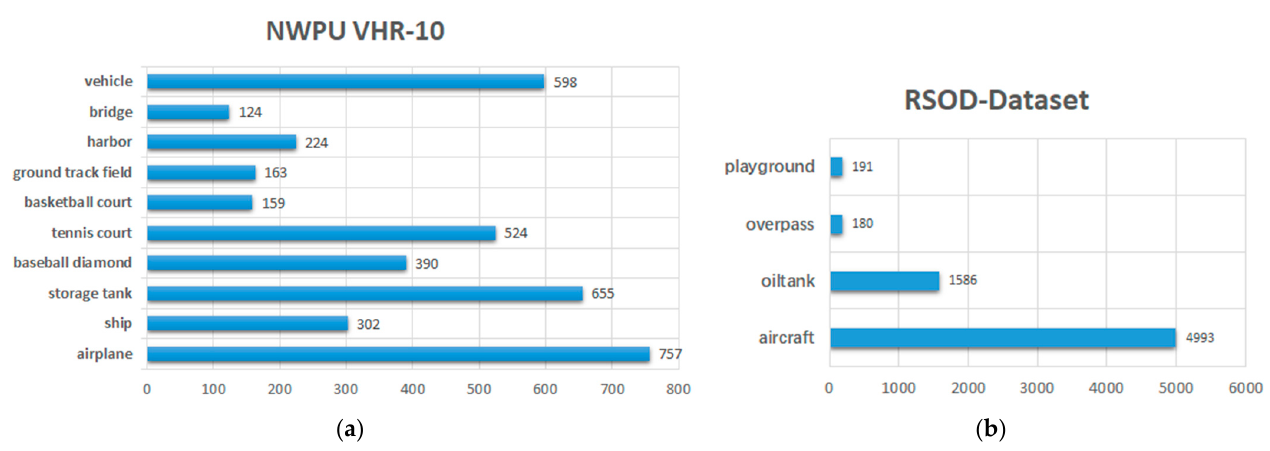
Figure 5. The categories and the number of instances of each category in two datasets. ( a ) NWPU VHR-10; ( b ) RSOD-Dataset. Compared with other datasets, NWPU VHR-10 contains more typical and comprehensive object category. Among them, the number of instances with larger scale is smaller compared to those with smaller scale, but the larger the scale of the instances, the more feature information they contain, and the easier they are to train.